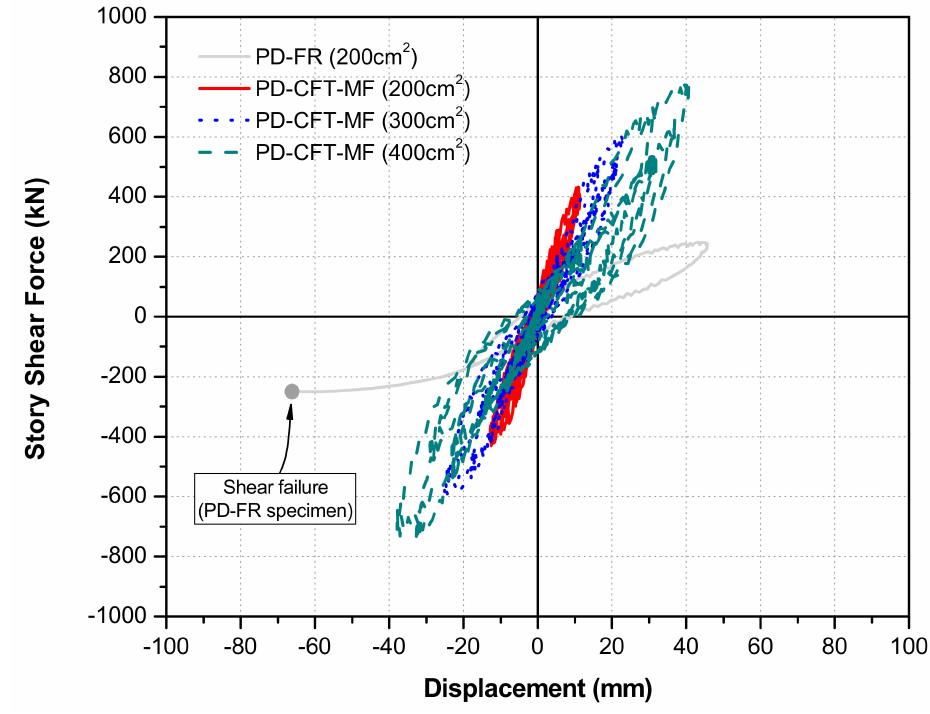
Figure 18. Comparison of seismic response load-displacement curves (first floor).